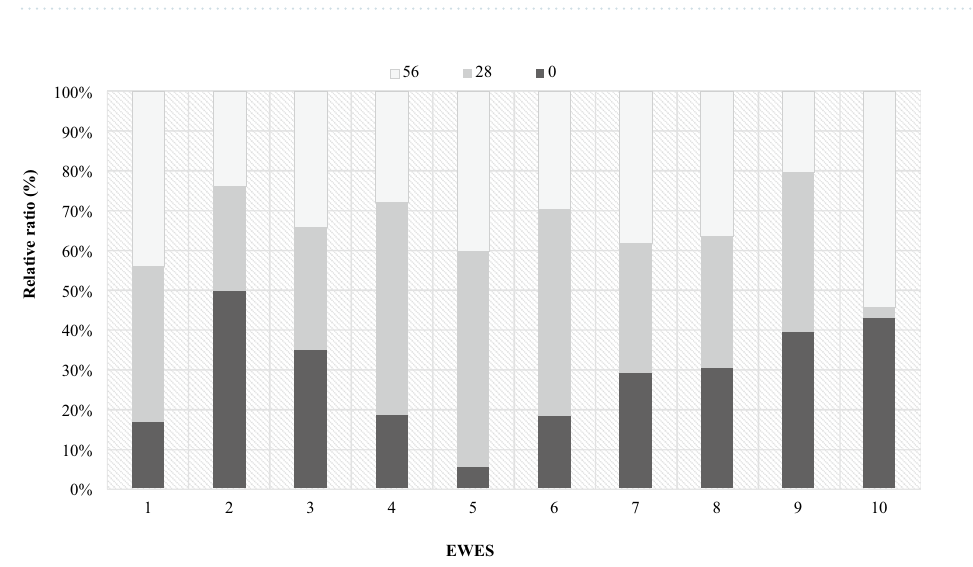
Figure 15. Relative ratio (%) of Lactobacillaceae in ewes feces depending on